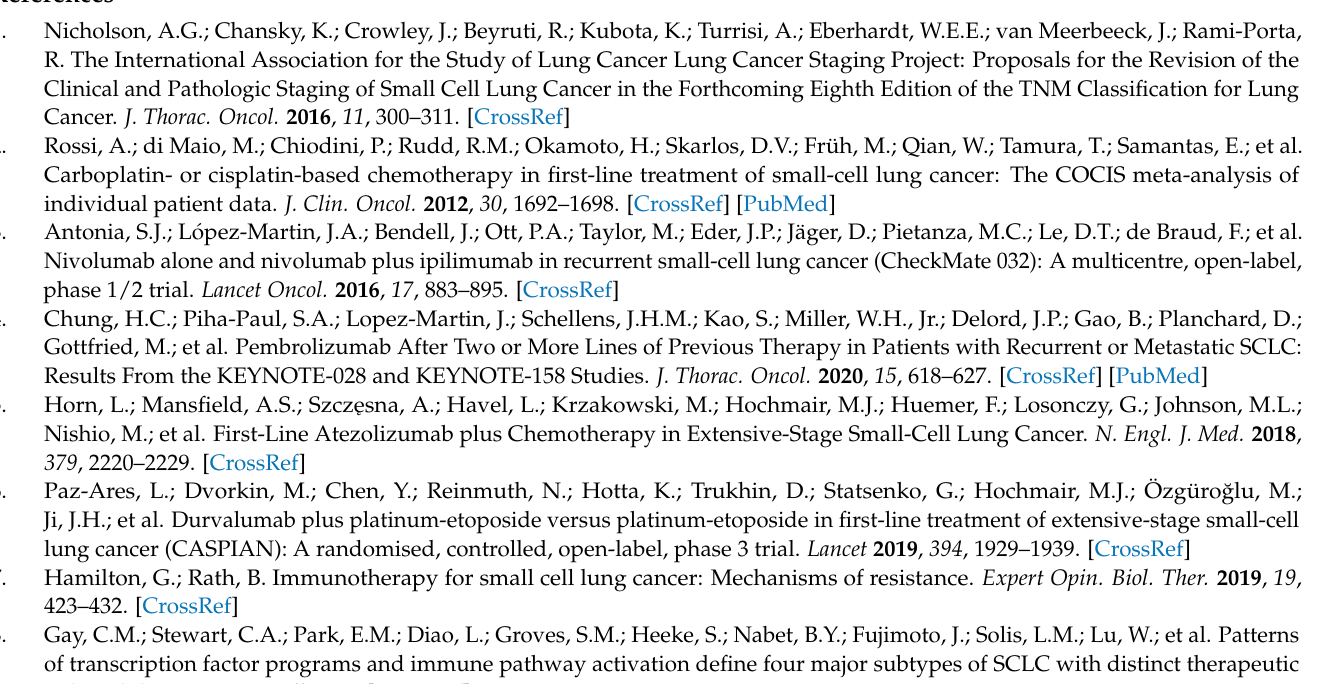
and H446 cells. Figure S5: c-Myc modulated HDAC3 to deacetylate histone H3K9ac at NKG2DL promoter in H446 cells. Figure S6: Correlation between MYC and NKG2DL expression levels in SCLC cells. Table S1: Primers of specific genes used for qRT-PCR. Table S2: Primers used for ChIP-qPCR. Table S3: The expression levels of MYC , MICA , MICB , ULBP1-3 mRNA in 18 SCLC-N cell lines (data form CCLE). File S1: Original Western blots